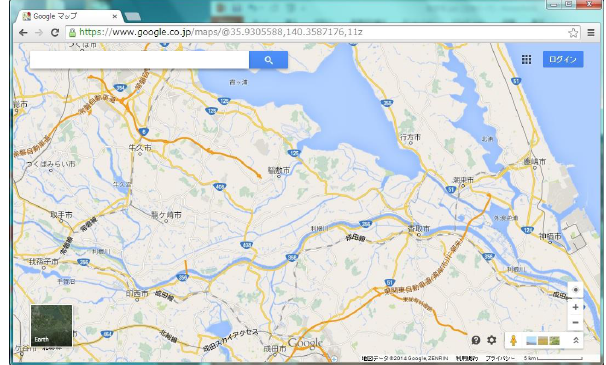
Figure 2. Map of the experiment